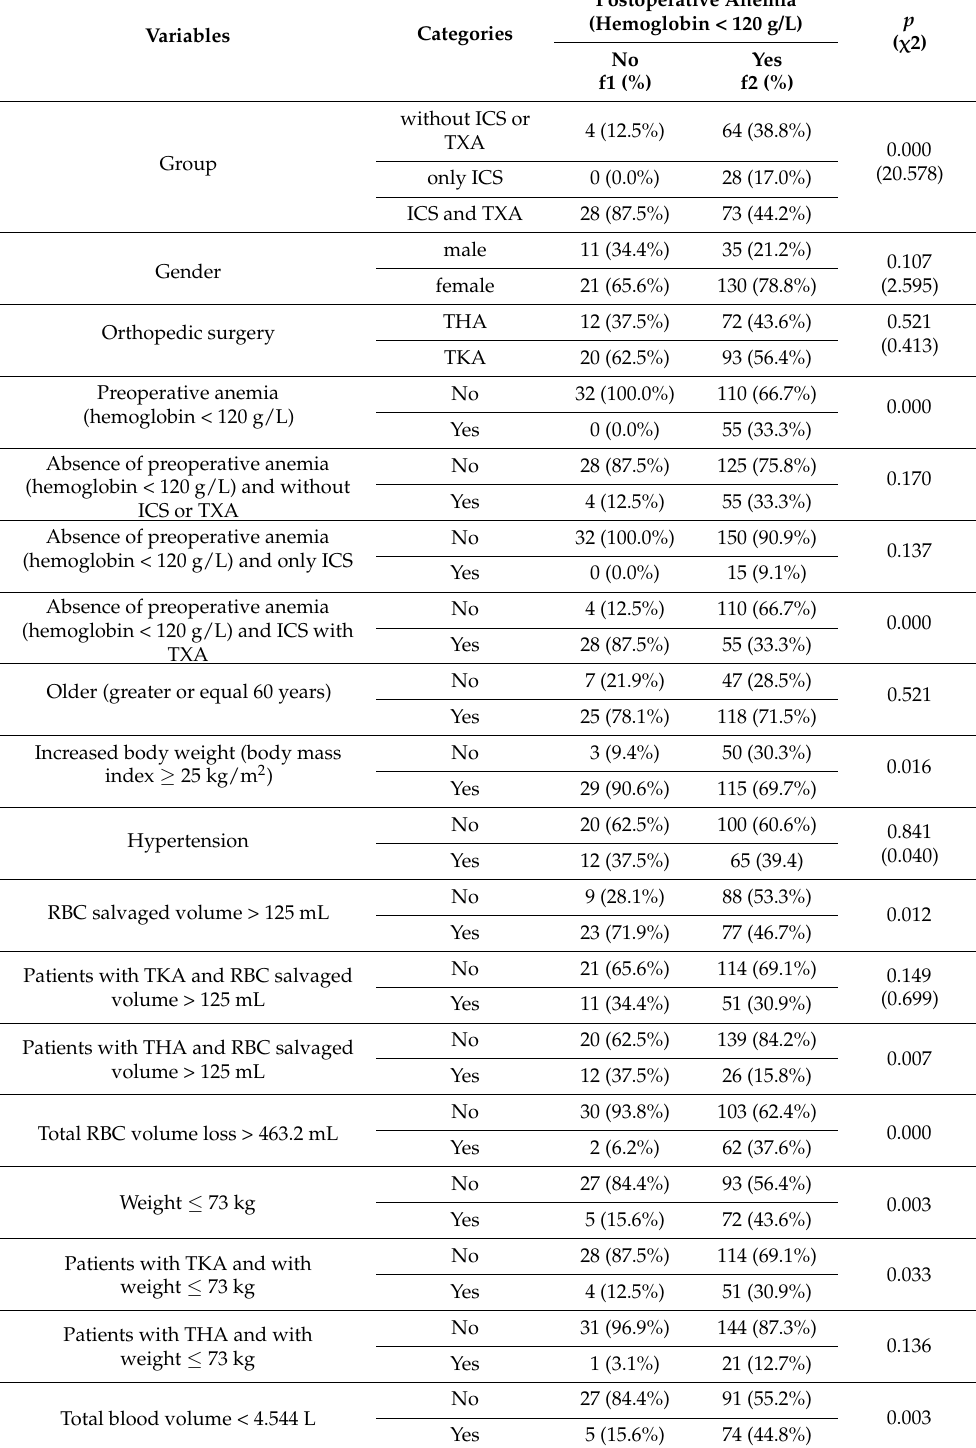
Table 4. Univariate analysis of frequency distribution differences between orthopedic patients without vs. patients with postoperative anemia, according to nominal